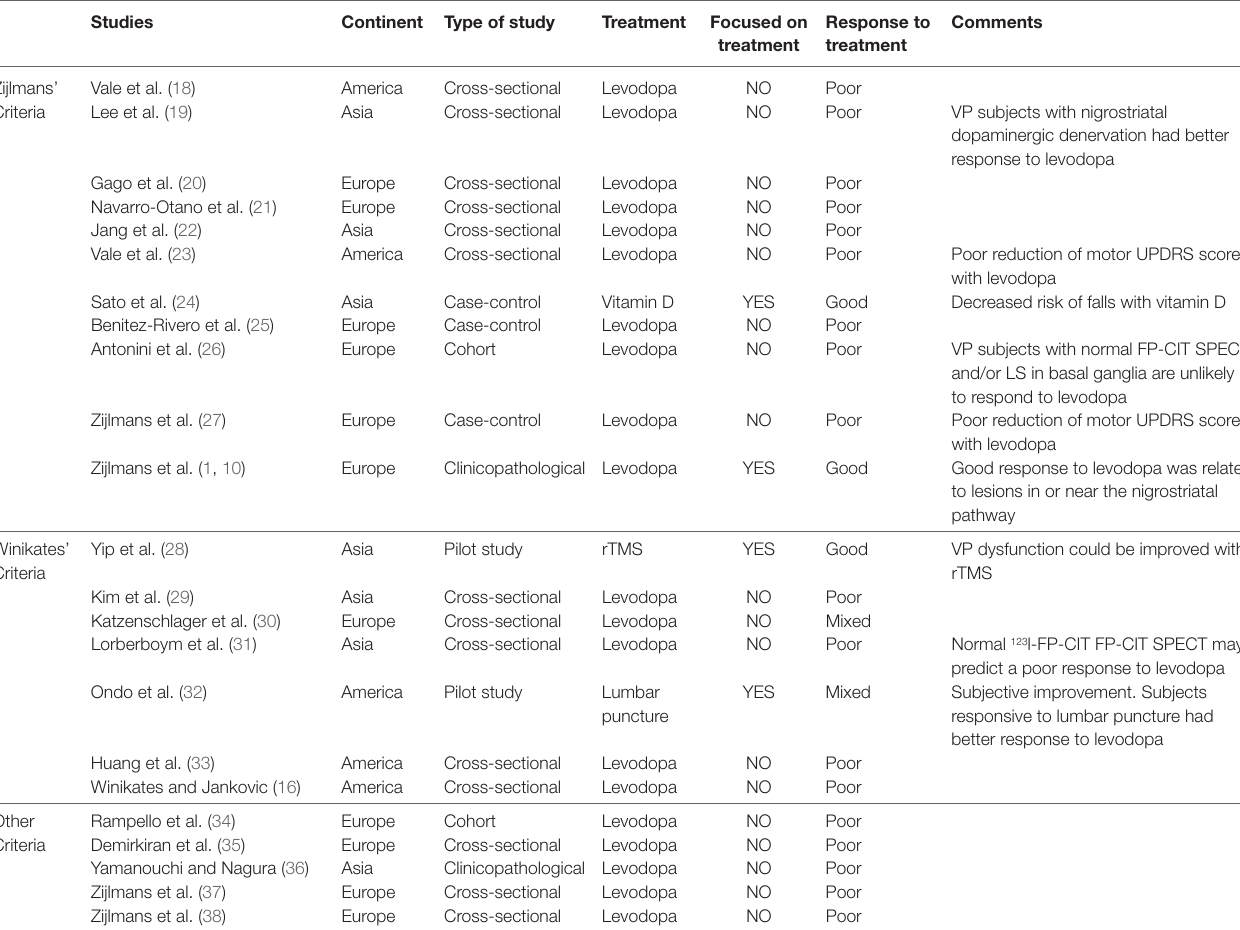
taBle 4 | Summary of included studies.